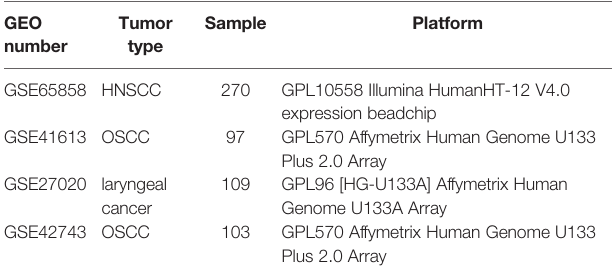
TABLE 1 | Detailed information of the test datasets on tumor type, sample, and